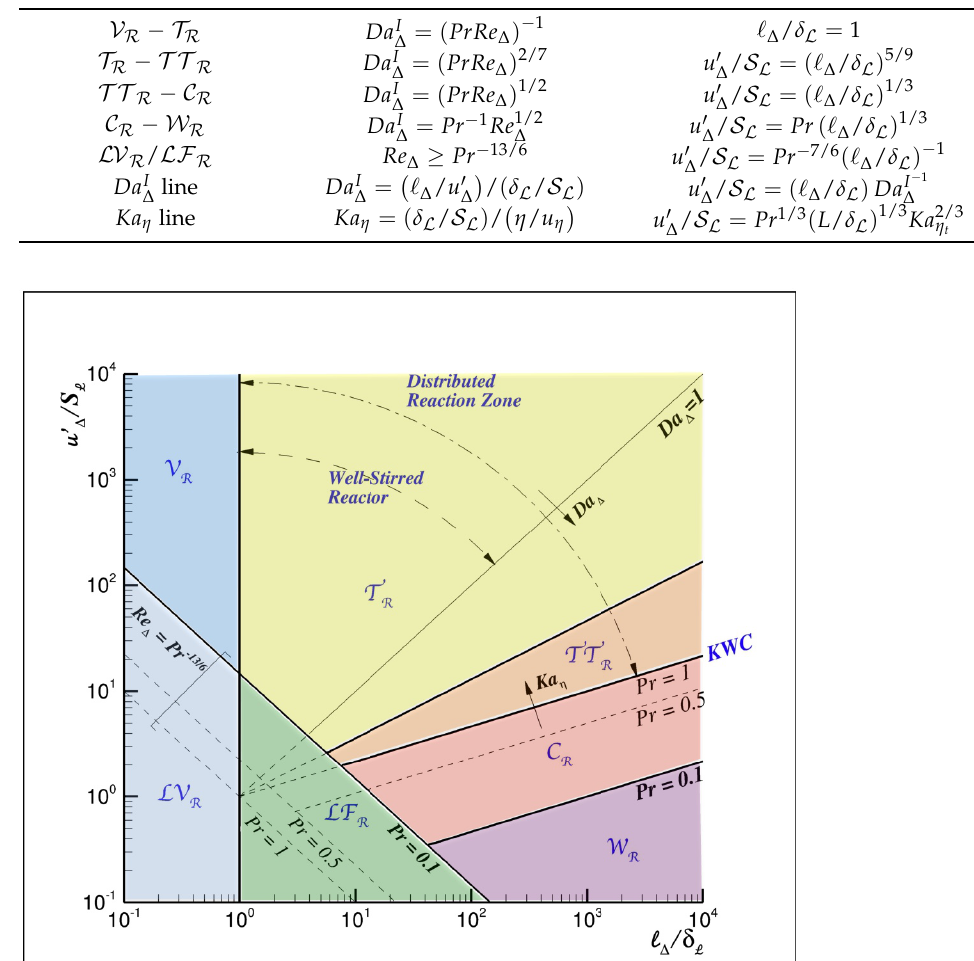
Table 3. Main boundaries of the LTSM combustion regimes shown in Figure 5.